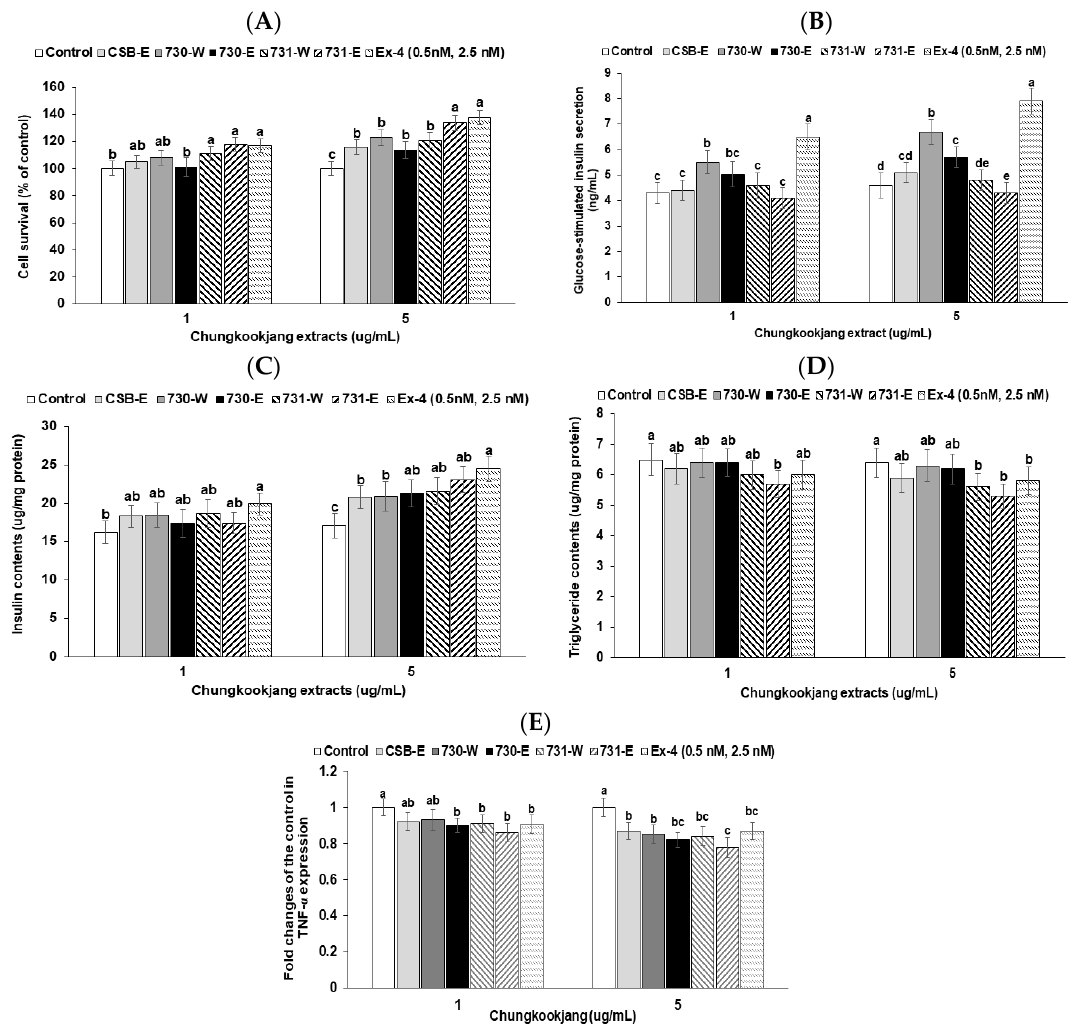
Figure 4. Glucose-stimulated insulin secretion, cell survival, insulin and triglyceride contents and TNF- α expression in insulinoma Min6 cells. Cell survival ( A ) was measured after 24 h treatment of vehicle or 5 µ g · mL − 1 of 70% ethanol (-E) or water extracts (-W) of chungkookjang fermented with B. amyloliquefaciens SRCM100730 (BA730) and SRCM100731 (BA731). Glucose-stimulated insulin secretion ( B ) measured in high glucose (20 mM) Krebs–Ringer–Hepes buffer for 30 min after